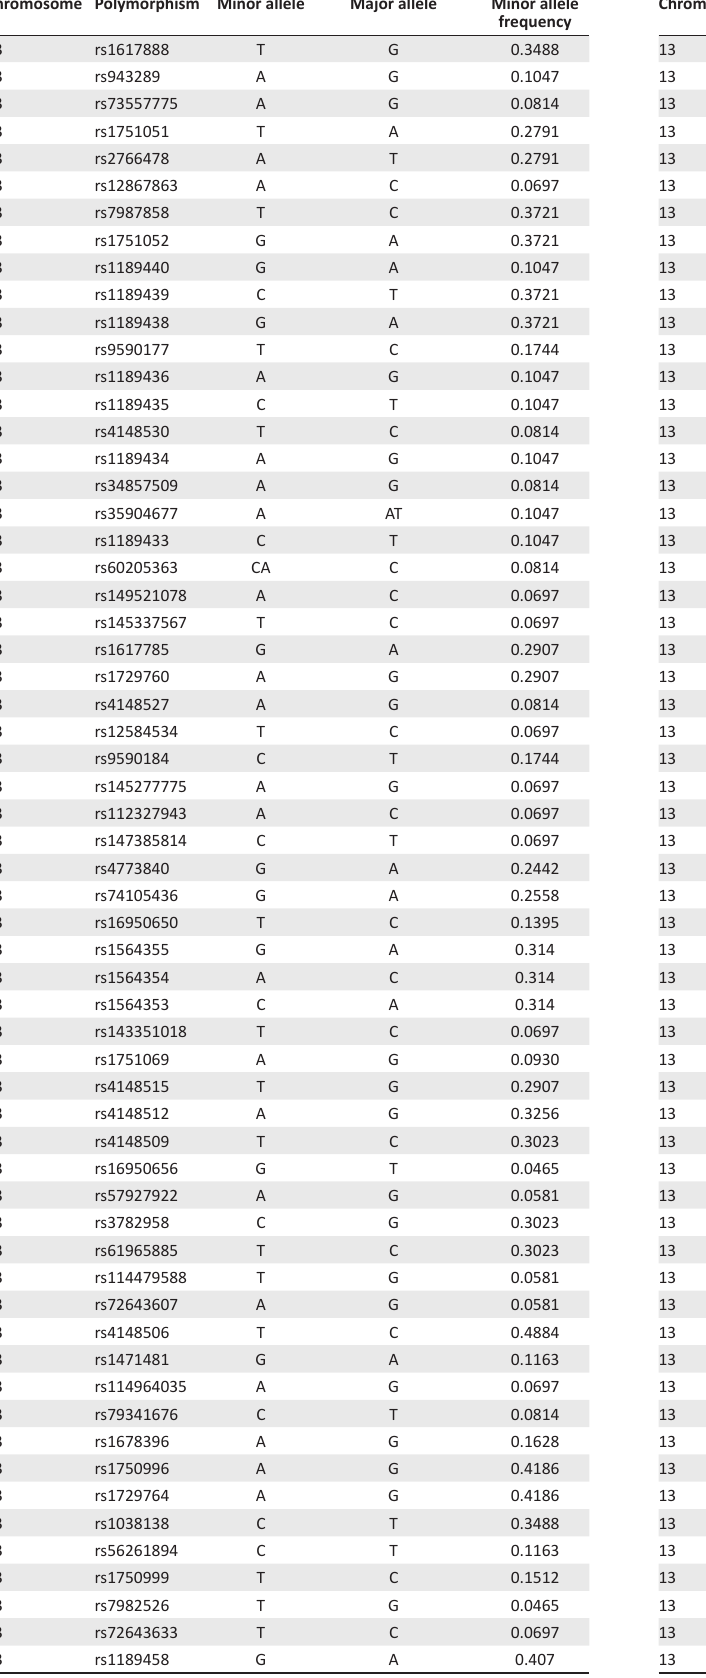
Table 1-A1 continues on the next page →Table 1-A1 continues in the next column